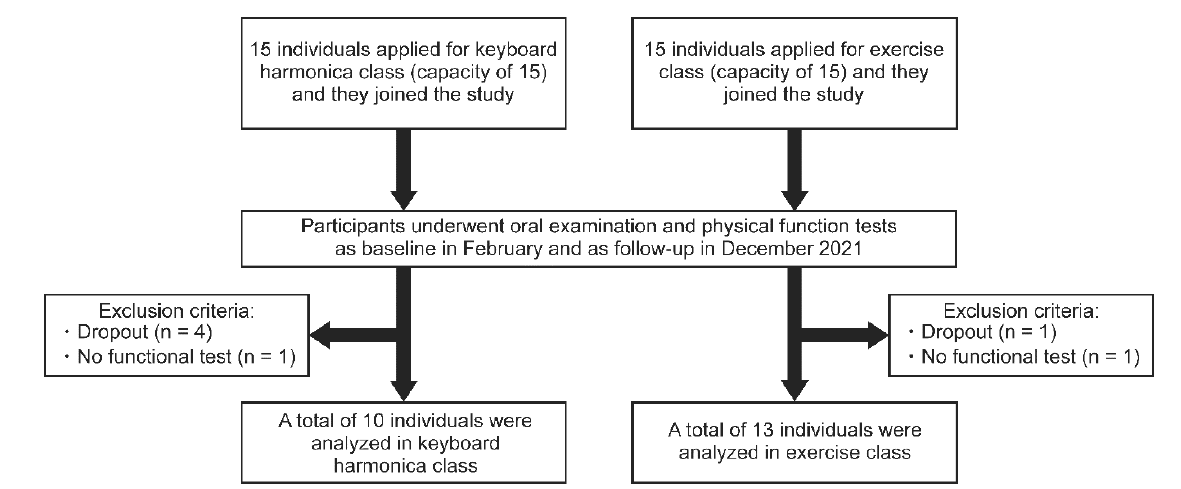
Figure 1. Flowchart of participant enrollment in the study.